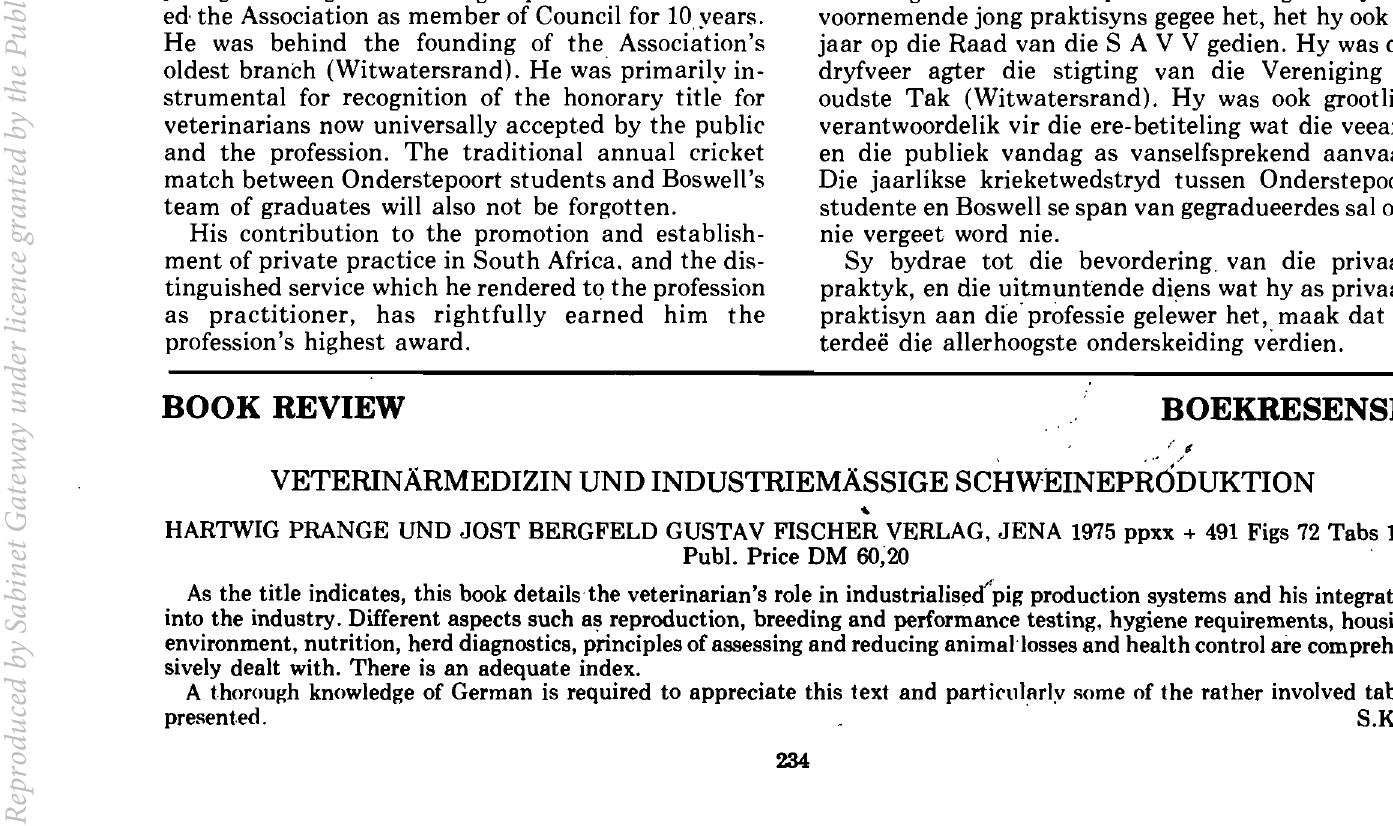
As the title indicates, this book details the veterinarian's role in industrialis~d/pig production systems and his integratiol into the industry. Different aspects such a~ reproduction, breeding and performance testing, hygiene requirements, housin~ environment, nutrition, herd diagnostics, principles of assessing and reducing animal losses and health control are comprehen sively dealt with. There is an adequate index. A thorough knowledge of German is required to appreciate this text and particulllrly some of the rather involved table